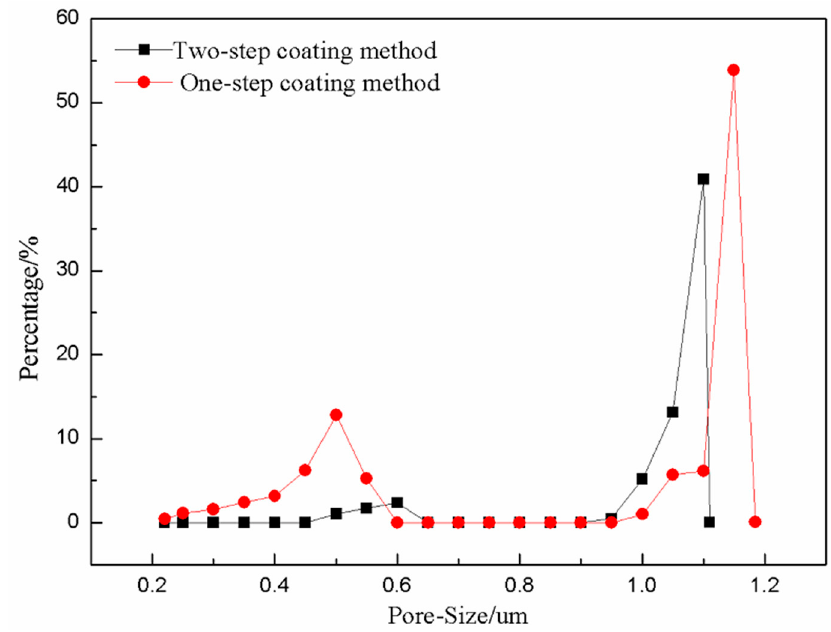
Figure 3. Pore-size distribution of ceramic membrane with 5 wt % solid content.